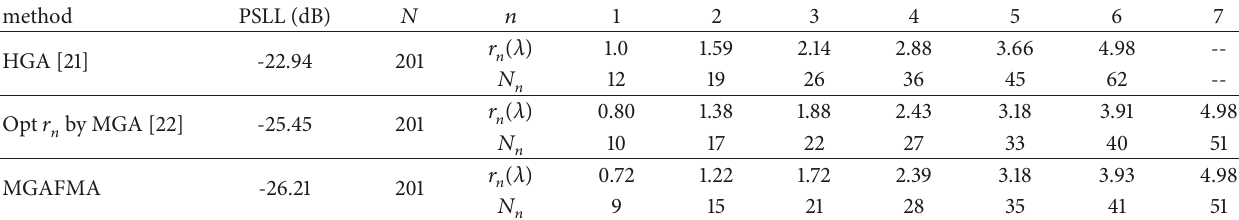
Table 3: Comparing the optimal result of 𝑁 = 201 and 𝐻 = 7 with [21, 22]. Function model algorithm using MGA (FMAMGA), element number ( 𝑁 ), ring radii ( 𝑟 𝑛 (𝜆) ), and element number in the rings ( 𝑁 𝑛 ). method